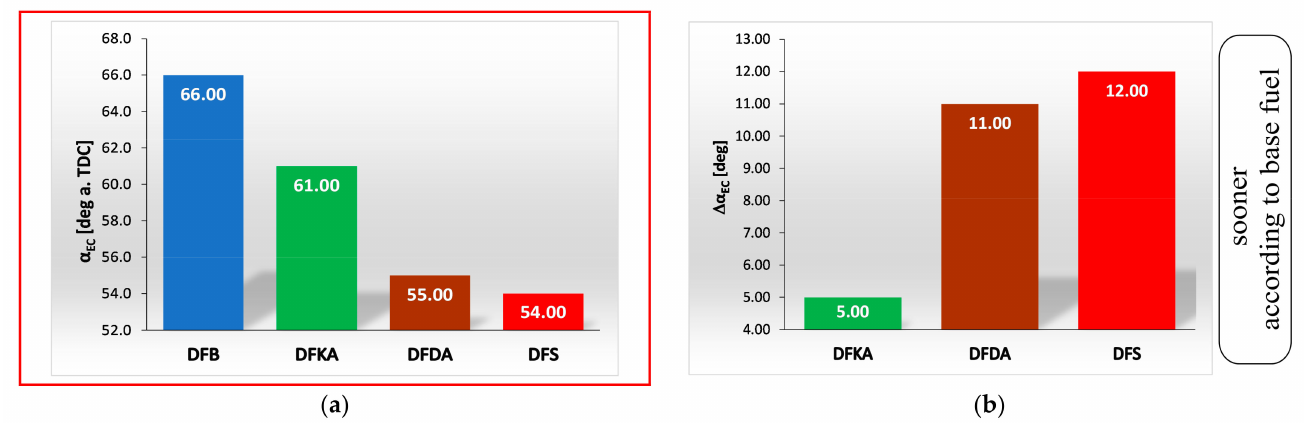
Figure 23. ( a ) End of combustion ( α EC ) for tested fuels. ( b ) Percent change in end of combustion ∆ α α EC for tested fuels relative to ( EC ) for DFB (base fuel).